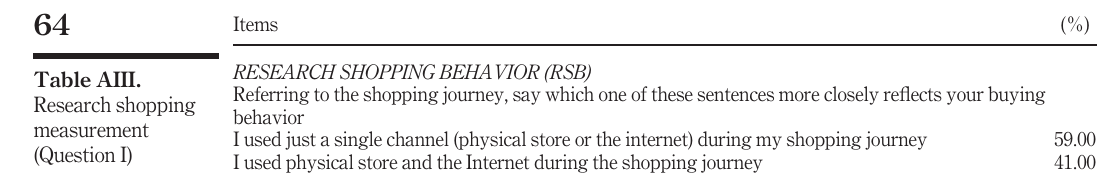
measurement (Question I)